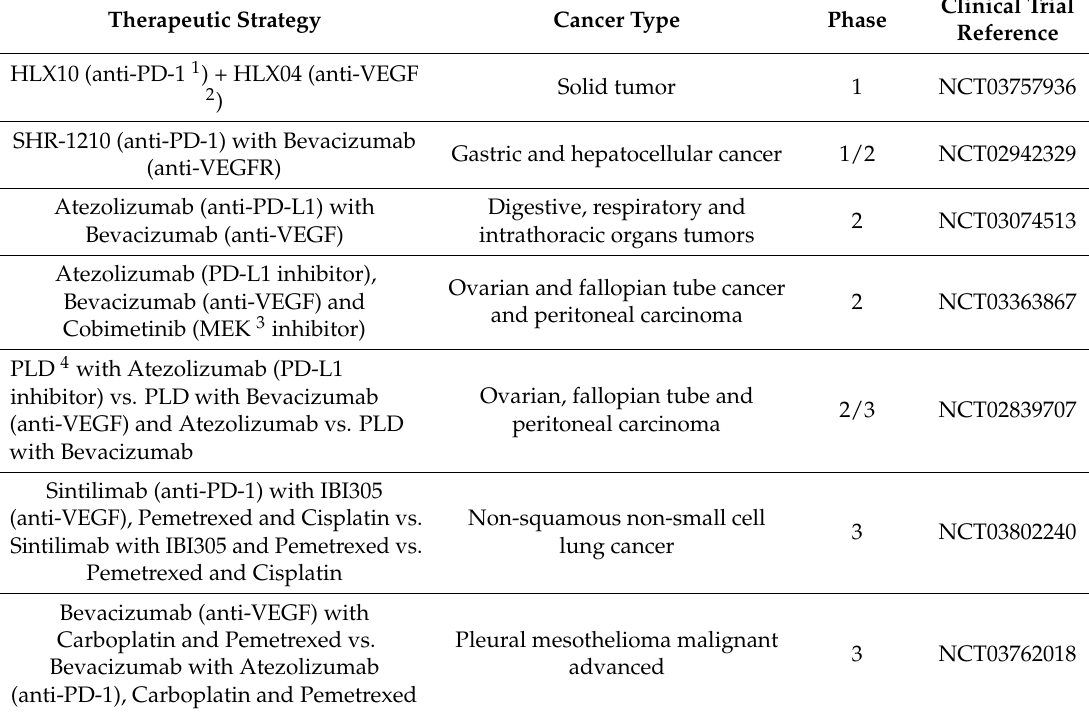
Table 4. Therapeutic agents for combinatorial therapy targeting the immune check point Programmed death 1 (PD-1) and angiogenesis in interventional clinical trials currently recruiting or not yet recruiting. Data acquired from the U.S. National library of medicine (http://clinicaltrials.gov, accessed on 16 January 2019). Therapeutic